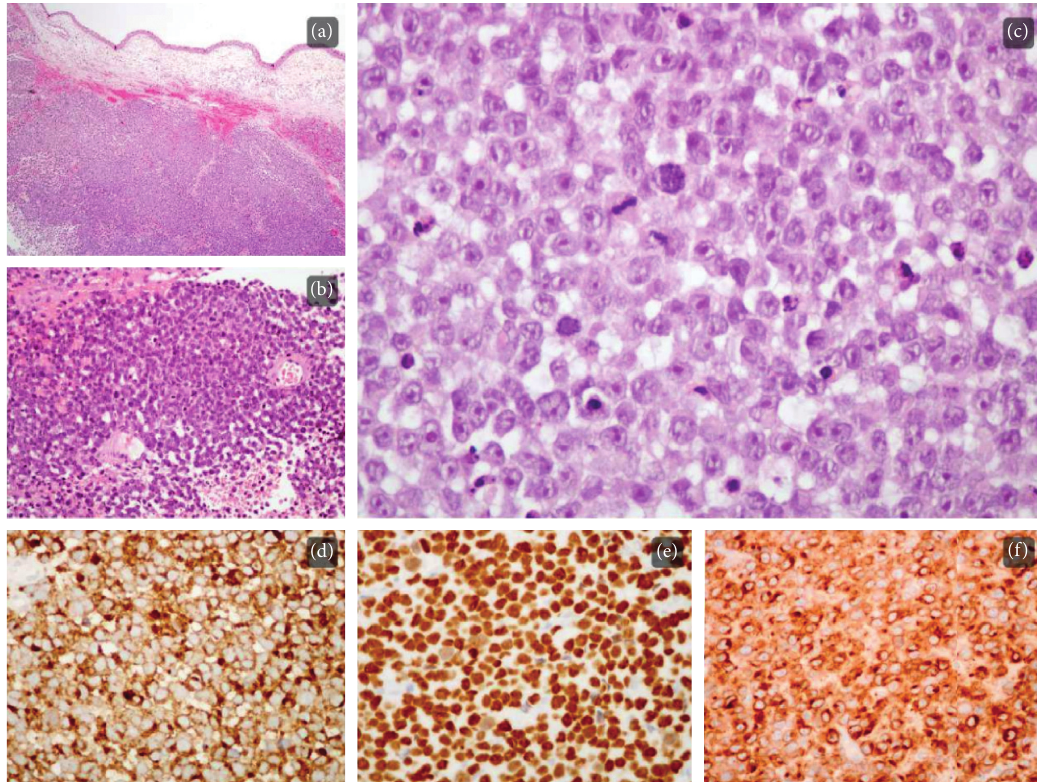
Figure 1: Microscopically, a solid tumor infiltrates the submucosa ((a); H&E, 40x), displaying areas of geographic necrosis ((b); H&E, 200x). On higher magnification ((c); H&E, 400x), cherry-red nucleoli are conspicuous and numerous mitosis and apoptosis figures can be recognized. Neoplastic cells were positive for HMB-45 ((d); 400x), SOX-10 ((e); 400x), and Melan-A ((f); 400x)